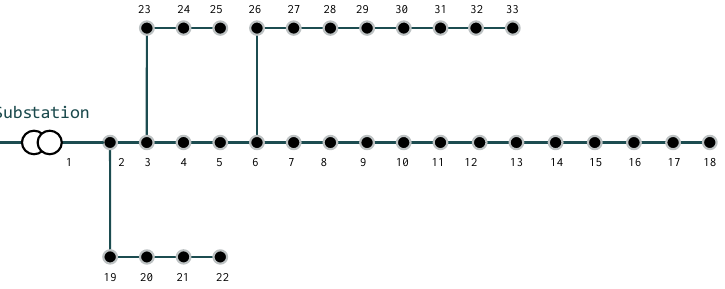
Figure 5. The single line diagram of the standard IEEE 33 bus system.